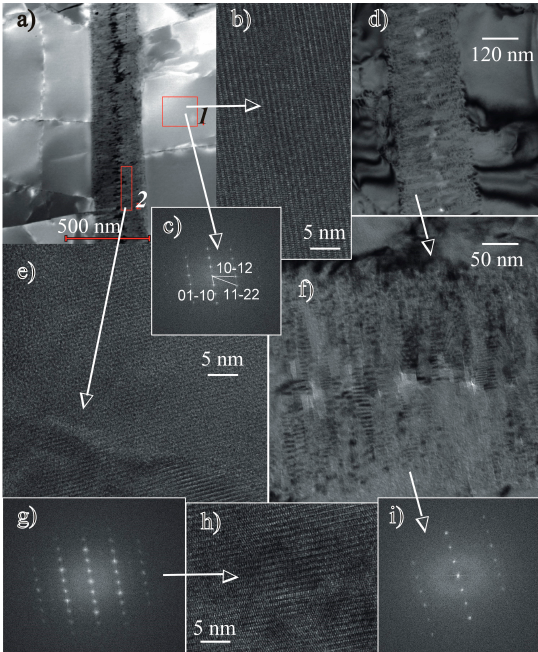
Figure 6. Transmission Electron Microscope ( TEM) photomicrographs of the two generations of apatite: ( a ) High-angle annular dark-field (HAADF) image of the first-generation fluorapatite with some chlorine (1) and a vein of fine-grained second-generation chlorine-free apatite in a crack (2); ( b – c ) lattice fringe image of early apatite and its indexed diffraction pattern (enlarged “a” image ); and ( d – i ) late apatite (second generation). The lath-shaped crystals nucleated on the walls of the cracks and grew towards the centre. The lattice fringe image of the late crystals and their diffraction pattern are indicative of apatite. The indices are the same as those shown in Figure 7c. Thus, the crystallographic orientation was identical between the first- and second-generation apatites.